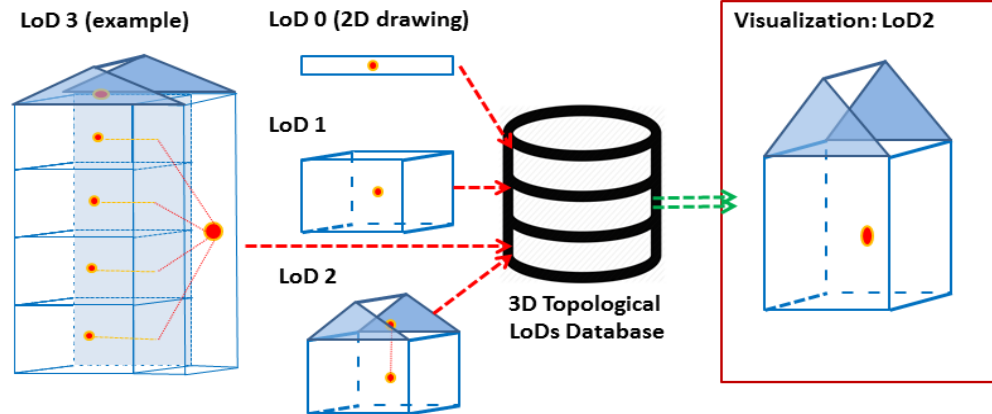
Figure 12. Simple illustration of overall topological